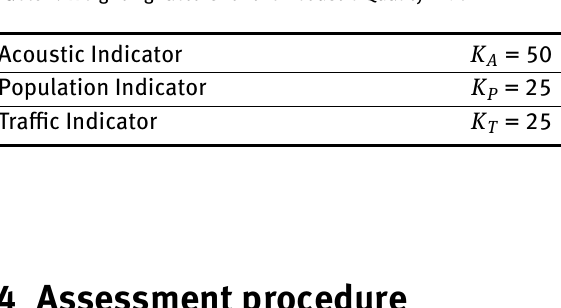
After obtaining the Indicators, the Index (AQI) can be estimated with the following Expr. 3, by assigning the rel- ative weights shown in Table 1. A global classification of the AQI values, corresponding to qualitative judgments, is proposed in Table 2.